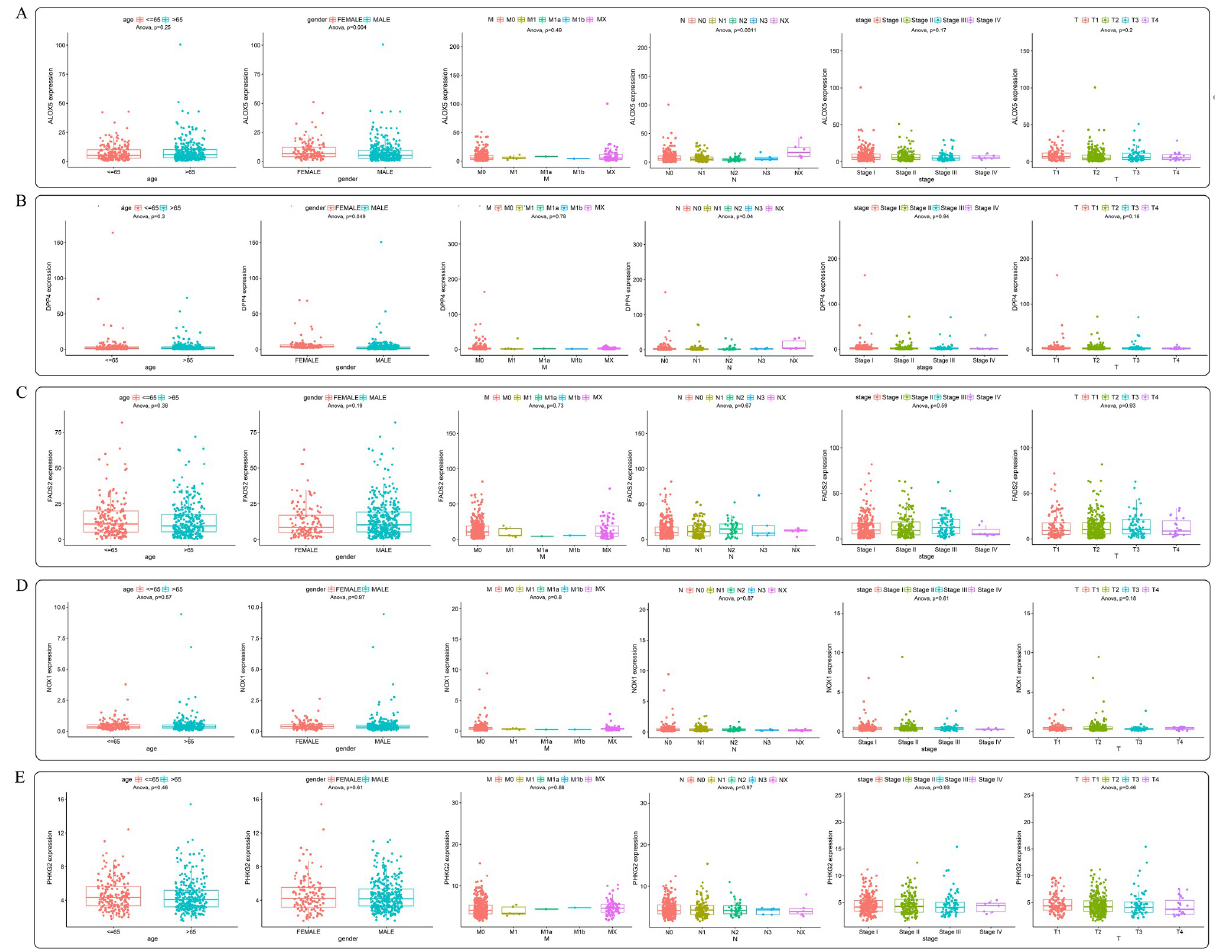
Fig 3. The correlation of 5 ferroptosis-associated genes expression with clinicopathological features in the TCGA cohort.